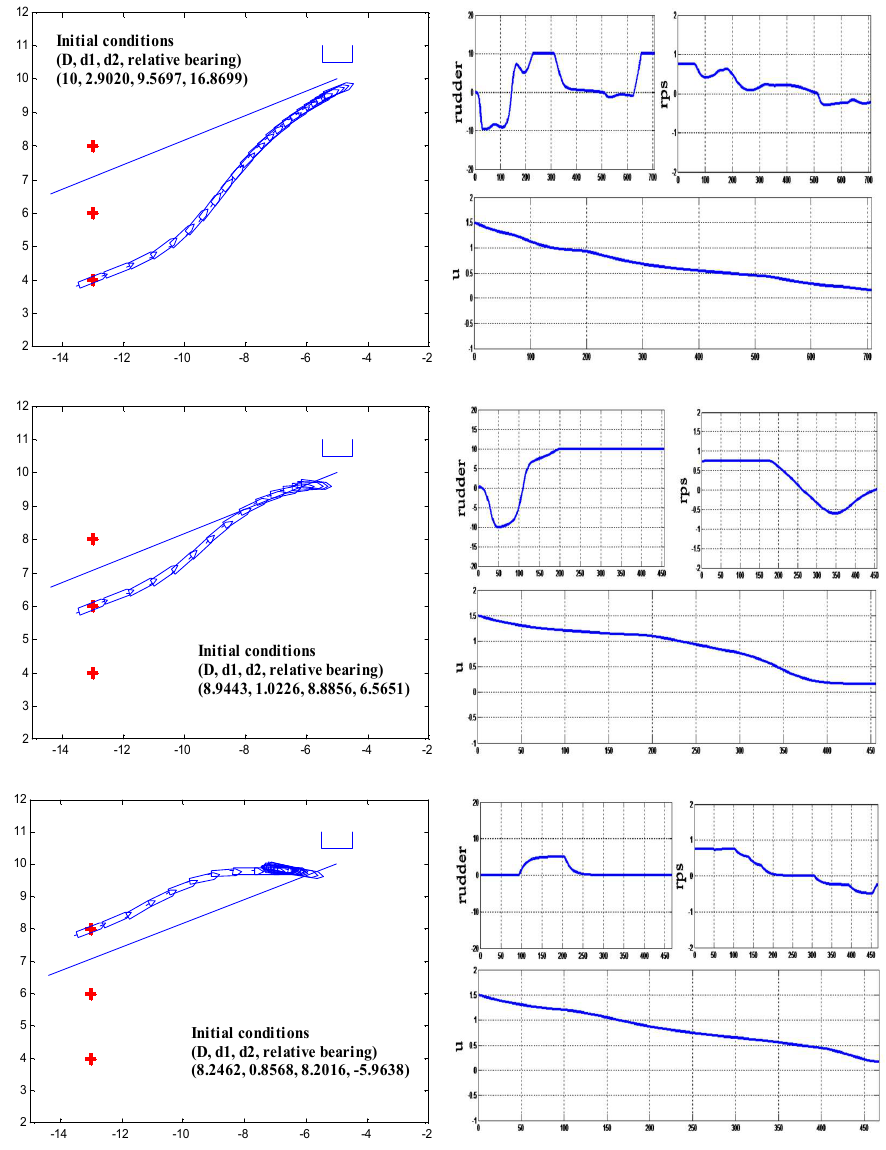
Figure 11. Automatic ship berthing in the different port.To verify the proposed controller for a real port, the ship was simulated for the automatic berthing in the Gamcheon area of Busan Harbor,